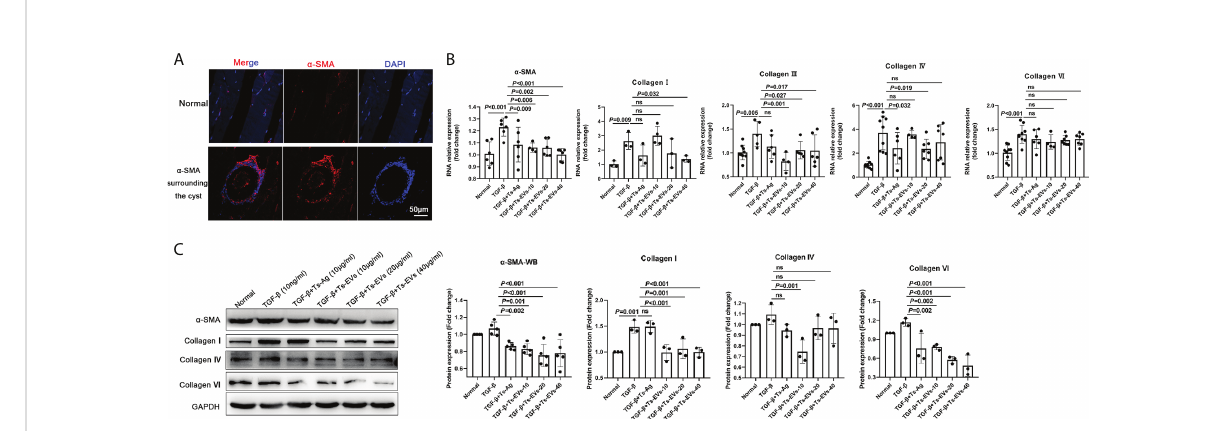
FIGURE 3 EVs (20 and 40 µg/mL) secreted by T. spiralis and T. spiralis soluble antigens (10 µg/mL) were used to stimulate human kidney fi broblasts (HKF), and qRT-PCR and western blotting were used to detect the levels of the fi brosis-related factors. (A) Fibroblasts surrounding the cyst of the larvae were labeled with a -SMA and observed using immuno fl uorescence. (B) The fi broblast activating factors were analyzed using RT-PCR. (C) The fi broblast activating factors were analyzed using western blotting. ns, no signi fi cant.